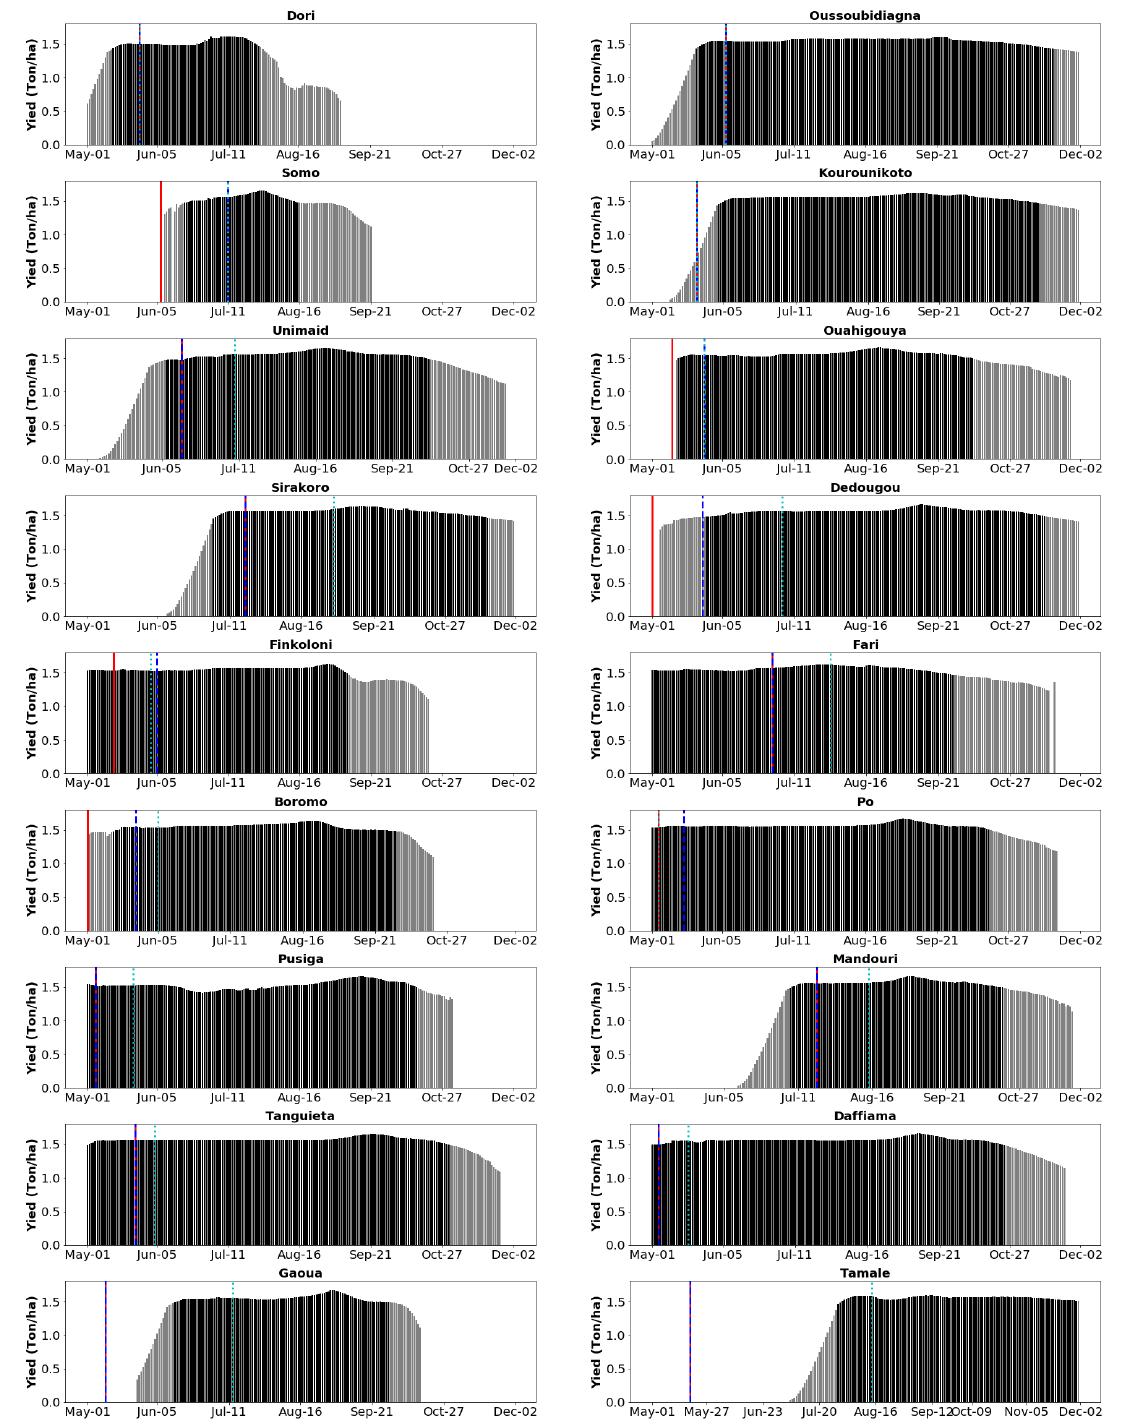
Figure 8. Variation of yield response to each date of the sowing window from 1st May to 31st November in 2020 expressed as bar chart for the available locations. The dark bars represent the safe windows and the vertical lines represent the different sowing based on the three definitions: (i) red for FP20mm, (ii) blue for LO20mm, and (iii) cyan for